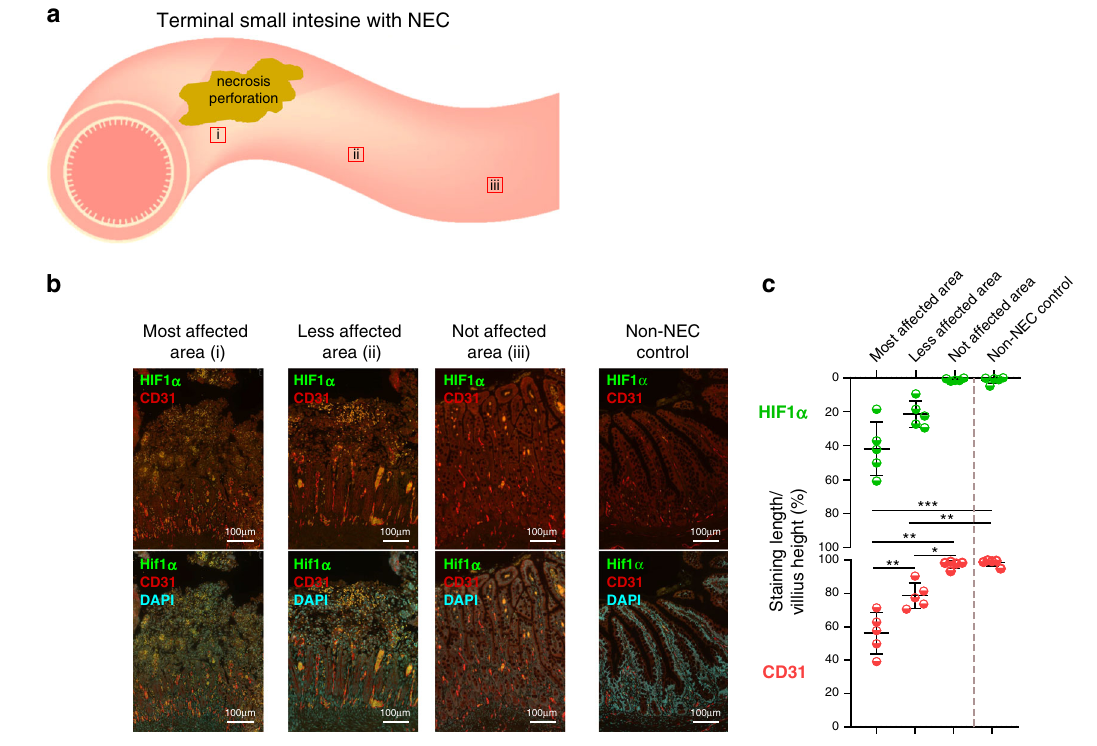
Fig. 1 Human NEC is associated with mucosal hypoxia and impairment of the microvasculature. a The terminal ileum of NEC patients ( n = 5) and non- NEC control patients ( n = 5) were analyzed and compared using immuno fl uorescence staining. b , c The intestine was divided into three regions: (i) the most affected ileum close to the area of necrosis and perforation ( n = 5), (ii) the less affected ileum distant from the necrosis/perforation ( n = 5), and (iii) the not affected ileum farther away from the damaged area ( n = 5). The most affected ileum had the highest expression of hypoxia-inducible factor 1 α (HIF1 α ) and the lowest expression of endothelial cell marker (CD31), compared to less affected, not affected areas and non-NEC controls. There was a progressive decrease in HIF1 α expression and progressive increase in CD31 expression from NEC-damaged to less damaged area. Immuno fl uorescence staining and imaging and analysis of slides were performed by blinded investigators and data werr compared using two-sided one-way ANOVA with post hoc Turkey test and repeated measure for the comparison of different areas within the NEC patient and no pairing comparison to the non-NEC control (* p < 0.05, ** p < 0.01, *** p < 0.001). Scale bars are equivalent to 100 µ m in all the images shown, and data are presented as mean ± SEM. Experiments were repeated independently 3 times, with similar results. Source data are provided as a Source Data fi